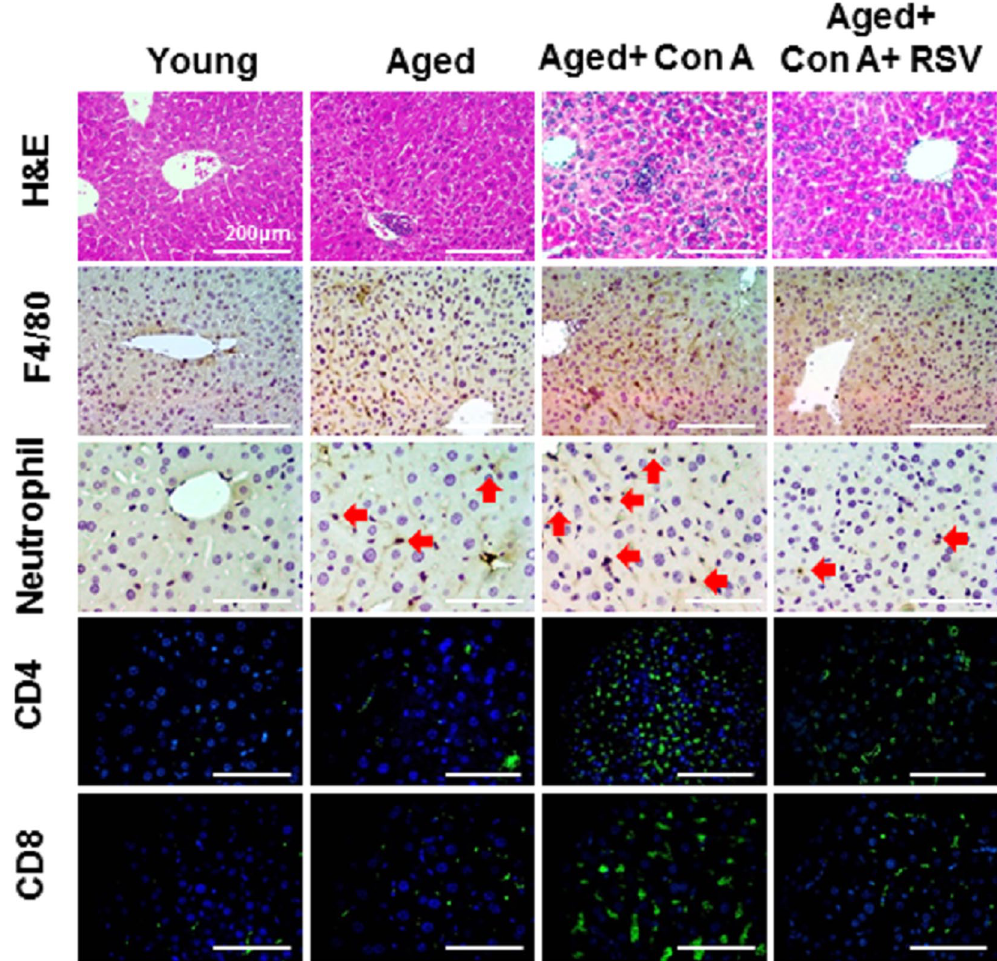
Figure 1. Resveratrol ameliorated Con A-induced histopathological change in the liver tissue of aged mice. H&E, IHC, and IF staining by group show infiltration of macrophages and neutrophils in liver (dark brown in color with red arrows indicating neutrophils; F4/80 and neutrophil stain, respectively). The T helper and T cytotoxic lymphocytes were stained with CD4 and CD8 antibodies, respectively. DAPI is the nuclear stain. All results are shown at 200 × magnification and the length of scale bar was indicated as 200 μ